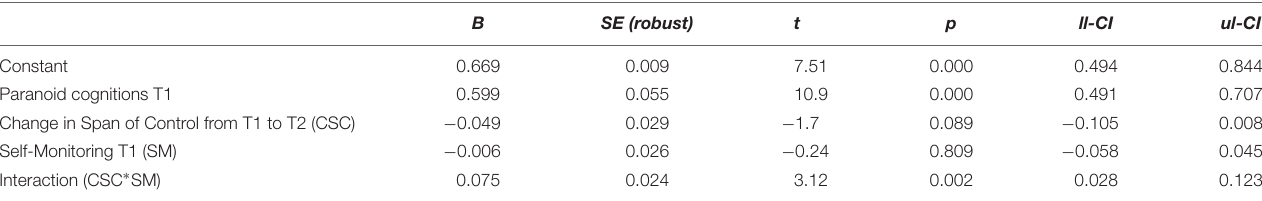
TABLE 3 | Regression model to explain change in paranoid cognitions (paranoid cognitions at T2 controlled for paranoid cognitions at T1) by change in span of control from T1 to T2 in a linear interaction with self-monitoring. B SE (robust)